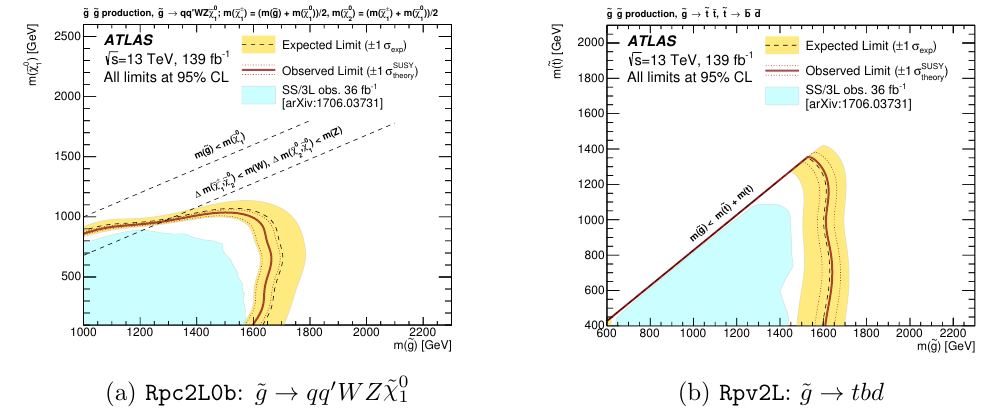
Figure 7. 95% CL exclusion limits on the production of pairs of gluinos, assuming production cross- sections as in ref. [27] and 100% branching ratios into the decay modes illustrated in (cid:12)gures 1(c) and 1(d) for the left and right plots, respectively. The limits are determined from the expected contributions of these processes to the Rpc2L0b (left) and Rpv2L (right) SRs. The coloured bands display the (cid:6) 1 (cid:27) ranges of the expected (cid:13)uctuations around the mean expected limit, in the absence of contributions from the sought-for signals. They do not account for uncertainties in the signal process cross-sections, the impact of which is illustrated by the dashed lines around the observed limits. The (cid:12)gures show for reference the reach of the previous analysis